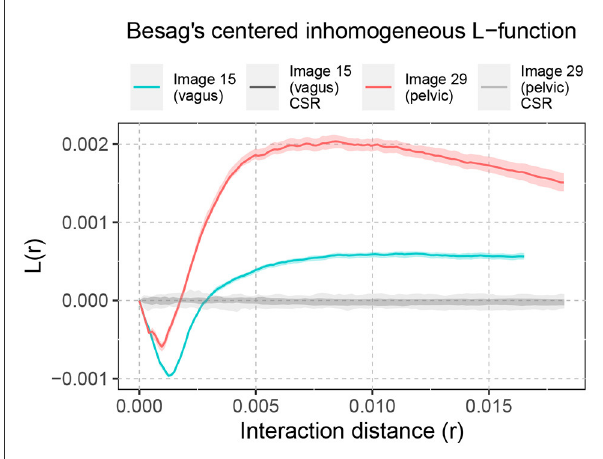
FIGURE5 Besag’s centered inhomogeneous L -function computed for Images 15 and 29. The shaded area around L ( r ) = 0 shows the significance bands of complete spatial randomness (CSR). The solid lines illustrate the non-random spatial arrangement of the point patterns compared to CSR. The shaded area around the solid lines shows the boundaries of 95-percentile confidence